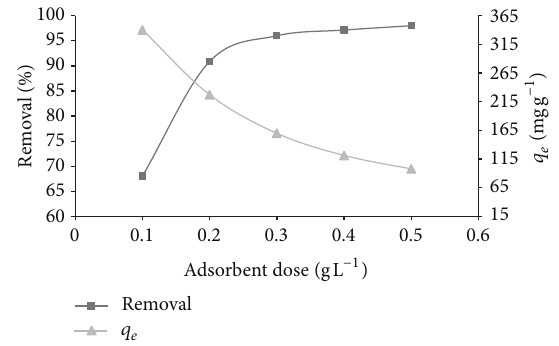
Figure 2: Effect of adsorbent dose (pH = 4 , 𝐶 𝑜 = 50 mgL −1 , 𝑡 = 120 min, A . S . = 150 rpm, 𝑇 = 298